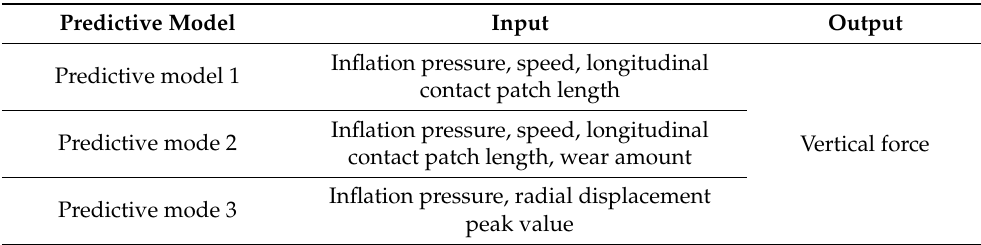
Table 2. Input characteristic parameters of each vertical force prediction model.